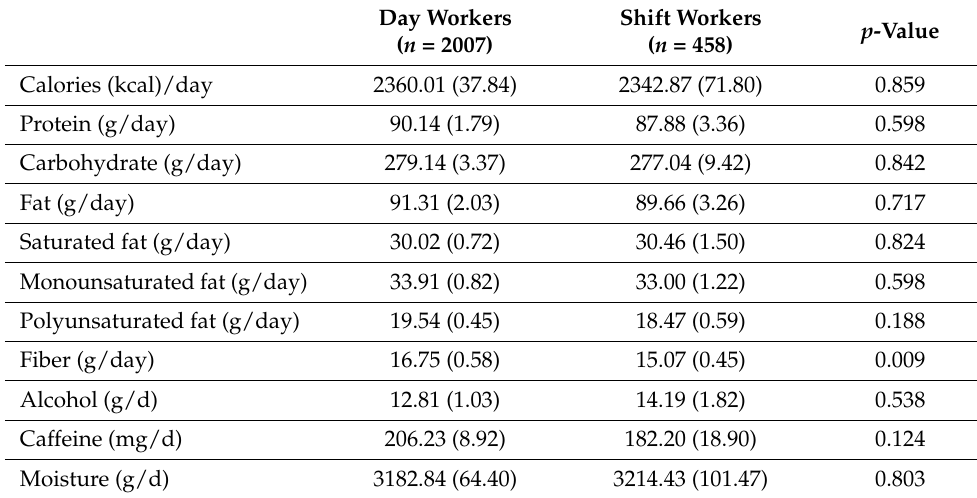
Table 2 legend: For continuous and normally-distributed variables, data are shown as mean (and standard error in parenthesis). Continuous variables were compared using STATA’s lincom (linear combinations of estimator) post-estimation command.